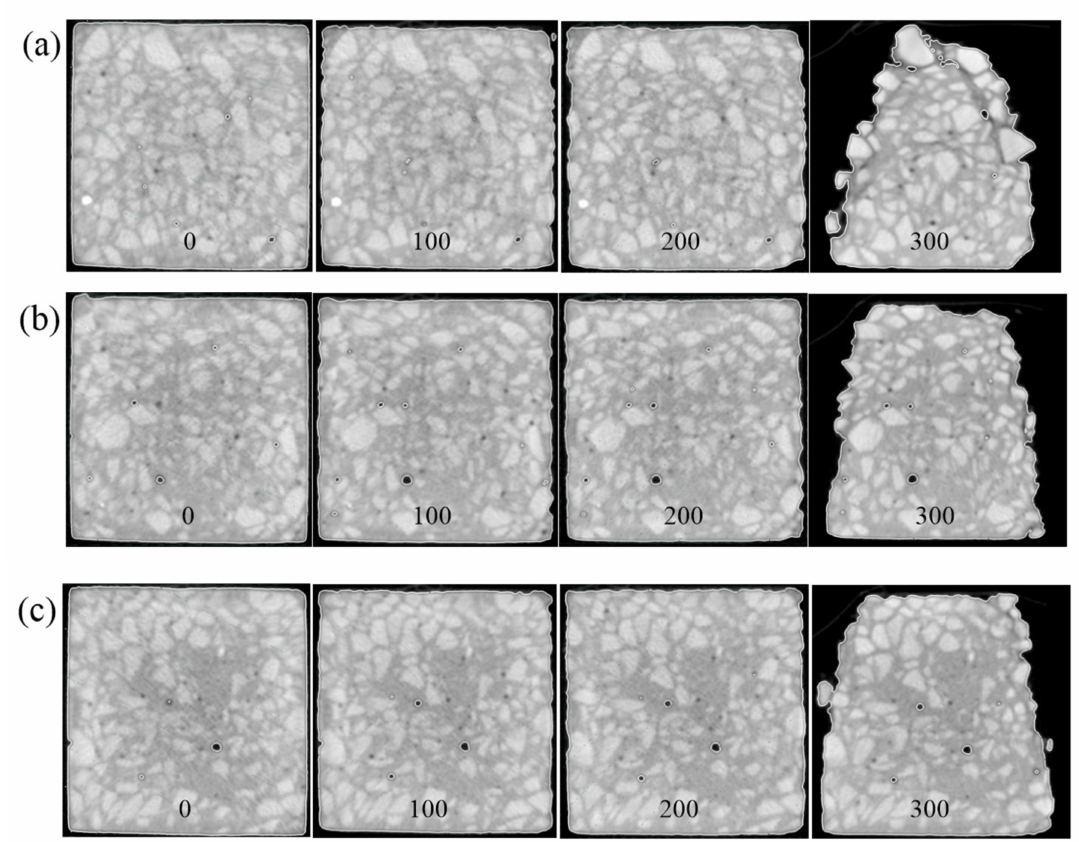
Figure 6. CT section images of concrete: ( a ) section 1; ( b ) section 2; ( c ) section